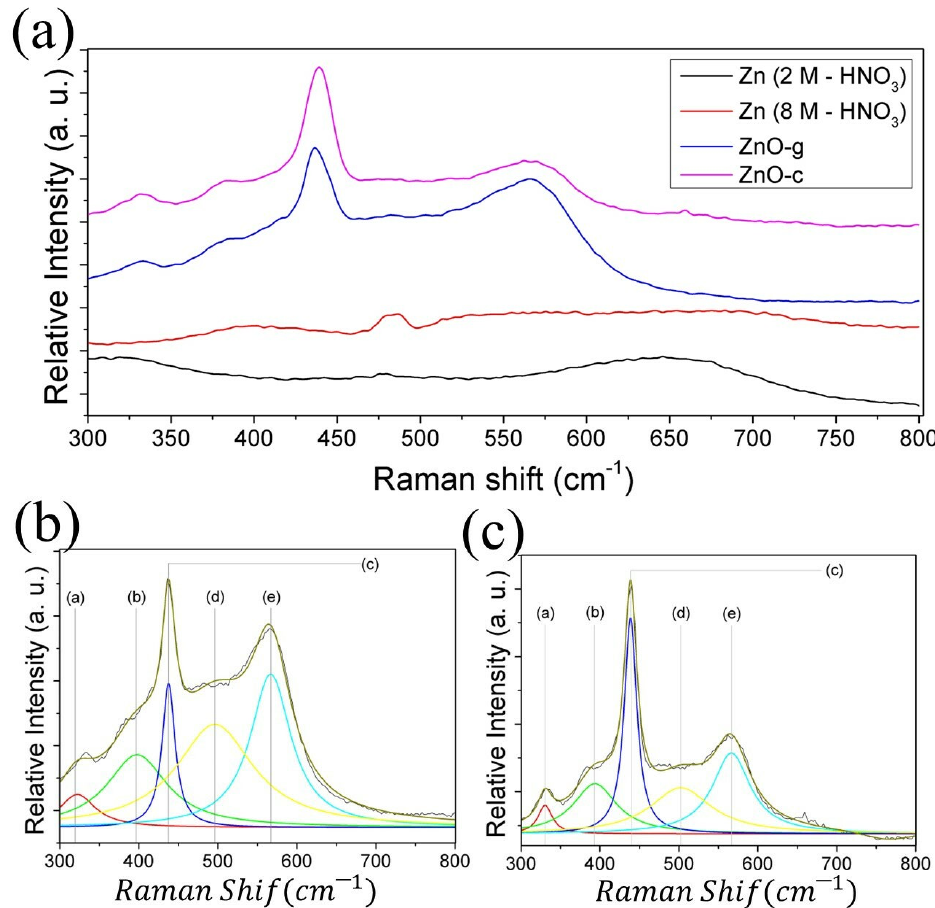
Figure 5. ( a ) Comparison of the recorded Raman shift between the Zn foil etched with HNO 3 2 M (Black line) and 8 M (red line), before and after TO (blue and magenta line, respectively). Lorentzian fit applied on the Raman shift recorded from ( b ) ZnO grass ‐ like and ( c ) ZnO cane ‐ like structures.